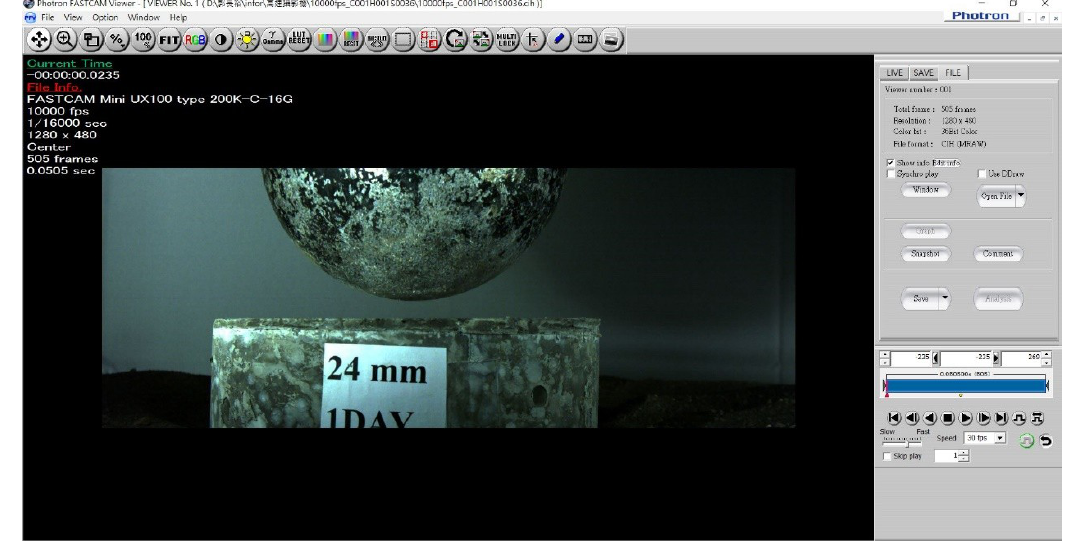
Materials 2019 , 12 , x FOR PEER REVIEW Figure 11. The image of benchmark specimen before the steel ball impact taken by high speed camera.